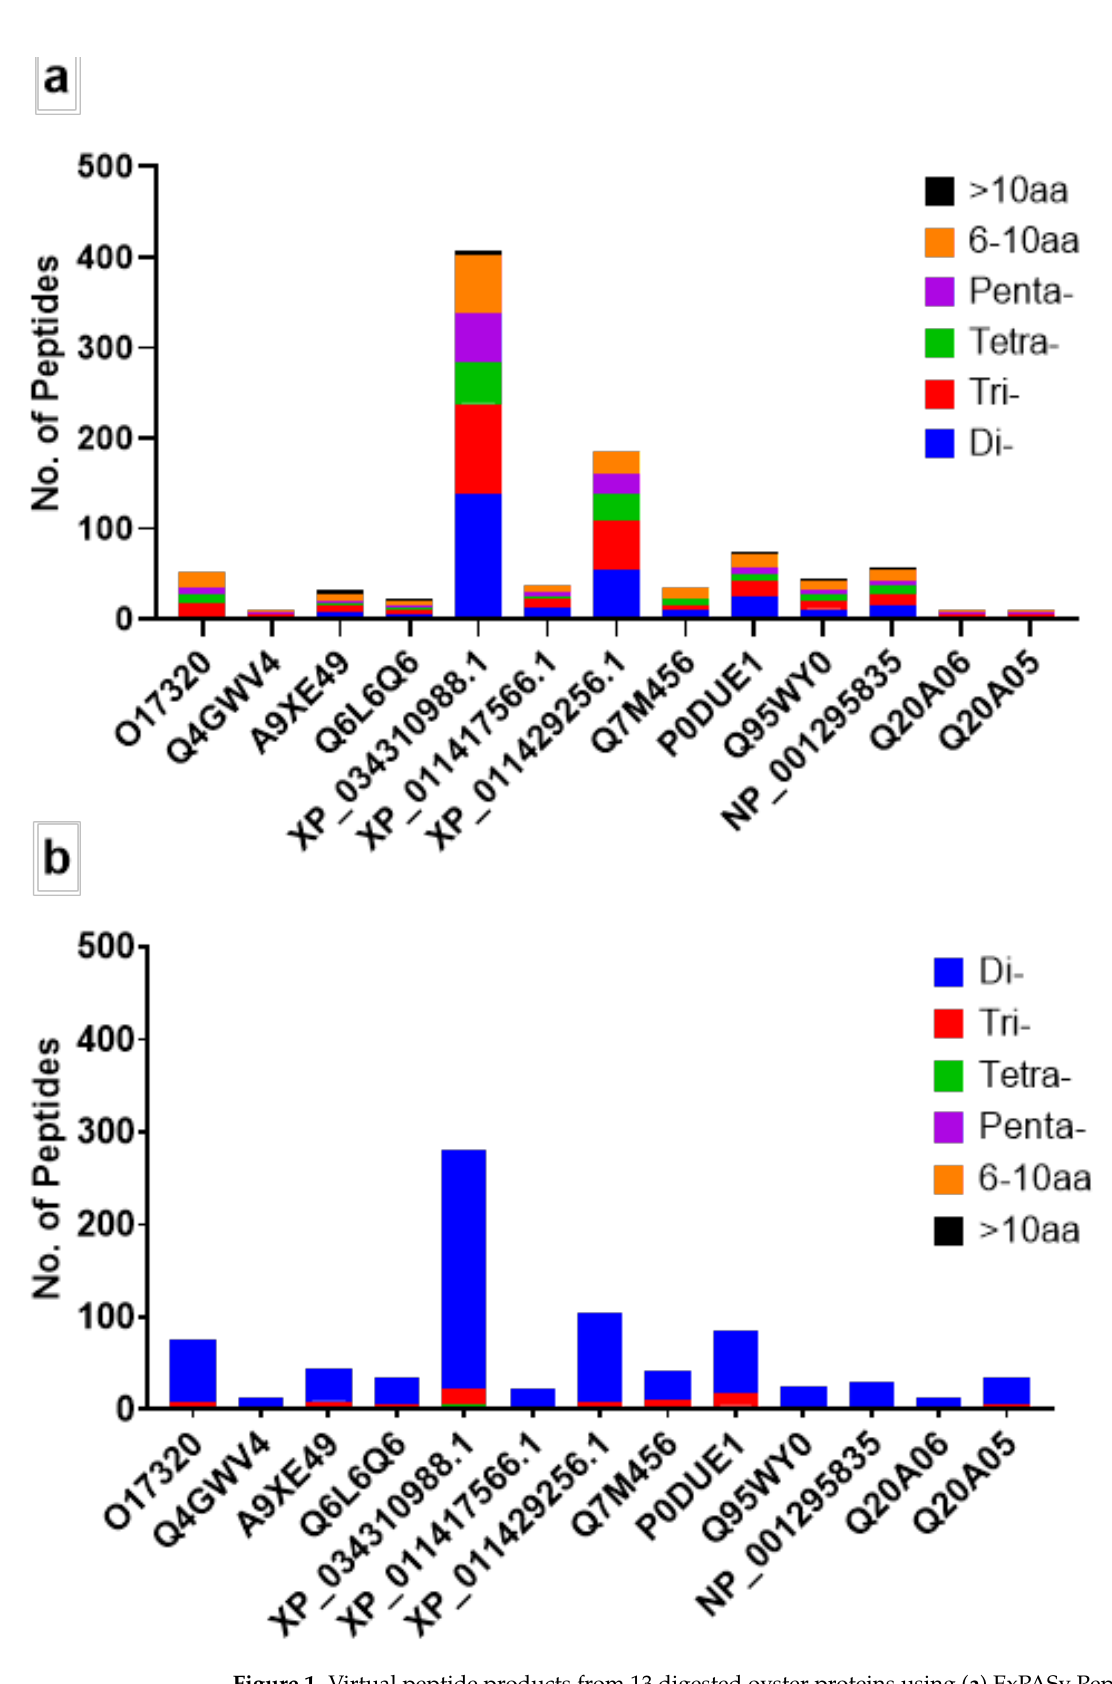
Figure 1. Virtual peptide products from 13 digested oyster proteins using ( a ) ExPASy PeptideCutter and ( b ) BIOPEP-UVM ’ s “ Enzyme Action ” tool.